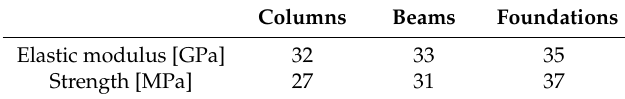
Table 1. Medium values of concrete characteristics obtained in situ by means of SonReb tests. Columns Beams